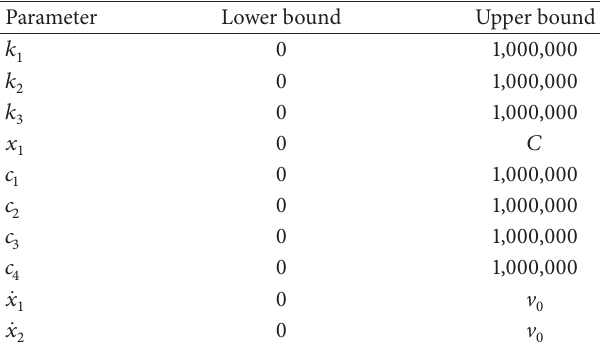
Table 4: Linear bounds for the model.